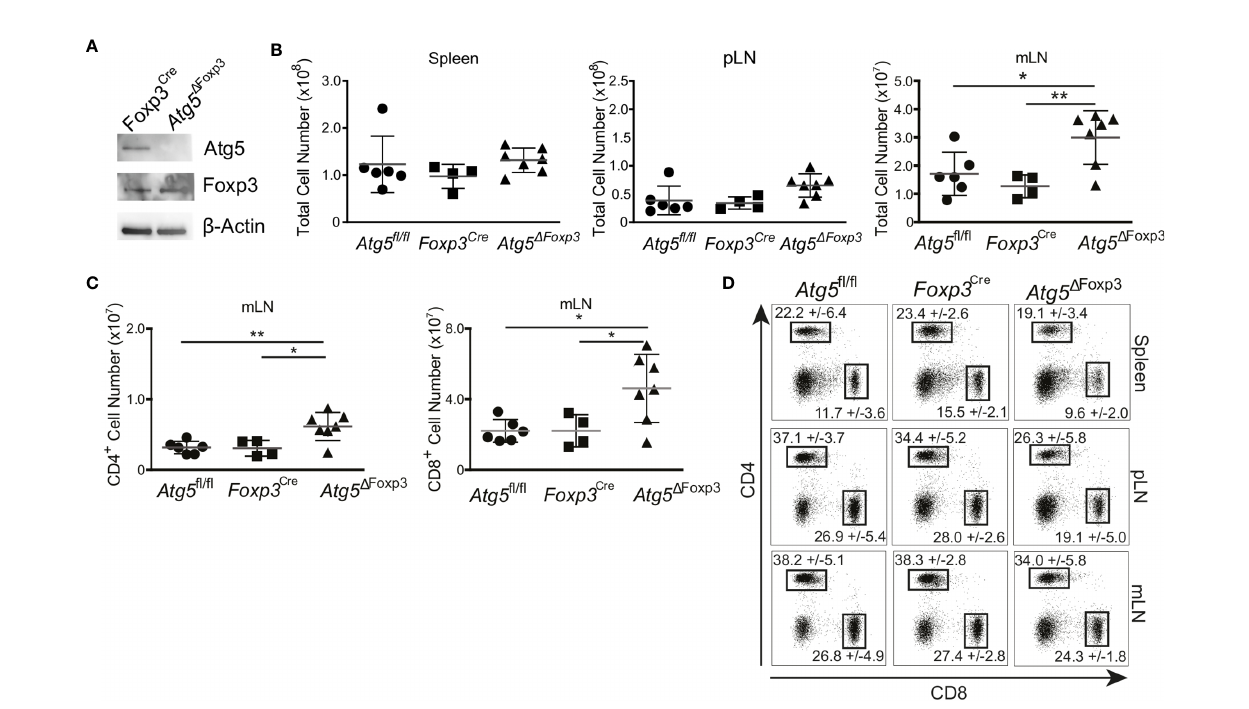
FIGURE 2 | Incipient intestinal immune system alteration of young Atg5 D Foxp3 mice. (A) Immunoblot analysis of Atg5 in FACS-puri fi ed Treg cells from Foxp3 Cre and Atg5 D Foxp3 mice. (B) Total cell numbers of spleen, peripheral lymph nodes (pLN) and mesenteric lymph nodes (mLN) from 8-week-old Atg5 fl /f , Foxp3 Cre and Atg5 D Foxp3 mice. (C) Total cell numbers of CD4 + and CD8 + T cell populations from mesenteric lymph nodes (mLN) of 8 weeks old Atg5 fl / fl , Foxp3 Cre and Atg5 D Foxp3 mice. (D) Representative dot plots of CD4- and CD8-expressing cell populations in 8-weeks-old Atg5 fl / fl , Foxp3 Cre and Atg5 D Foxp3 mice. Mean and SD are indicated; n=4-7. (B, C) The Kruskal – Wallis one-way ANOVA tests were used for statistical analysis. Mean ± SEM are given. Each symbol represents a single mouse in scatter plots. *p < 0.05, **p <